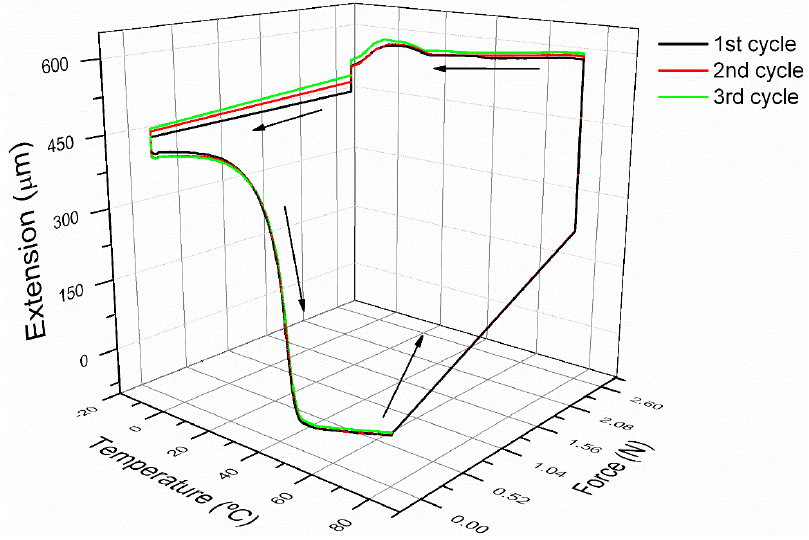
Figure 8. Shape memory capabilities in tension mode of PCO+2%DCP sample.